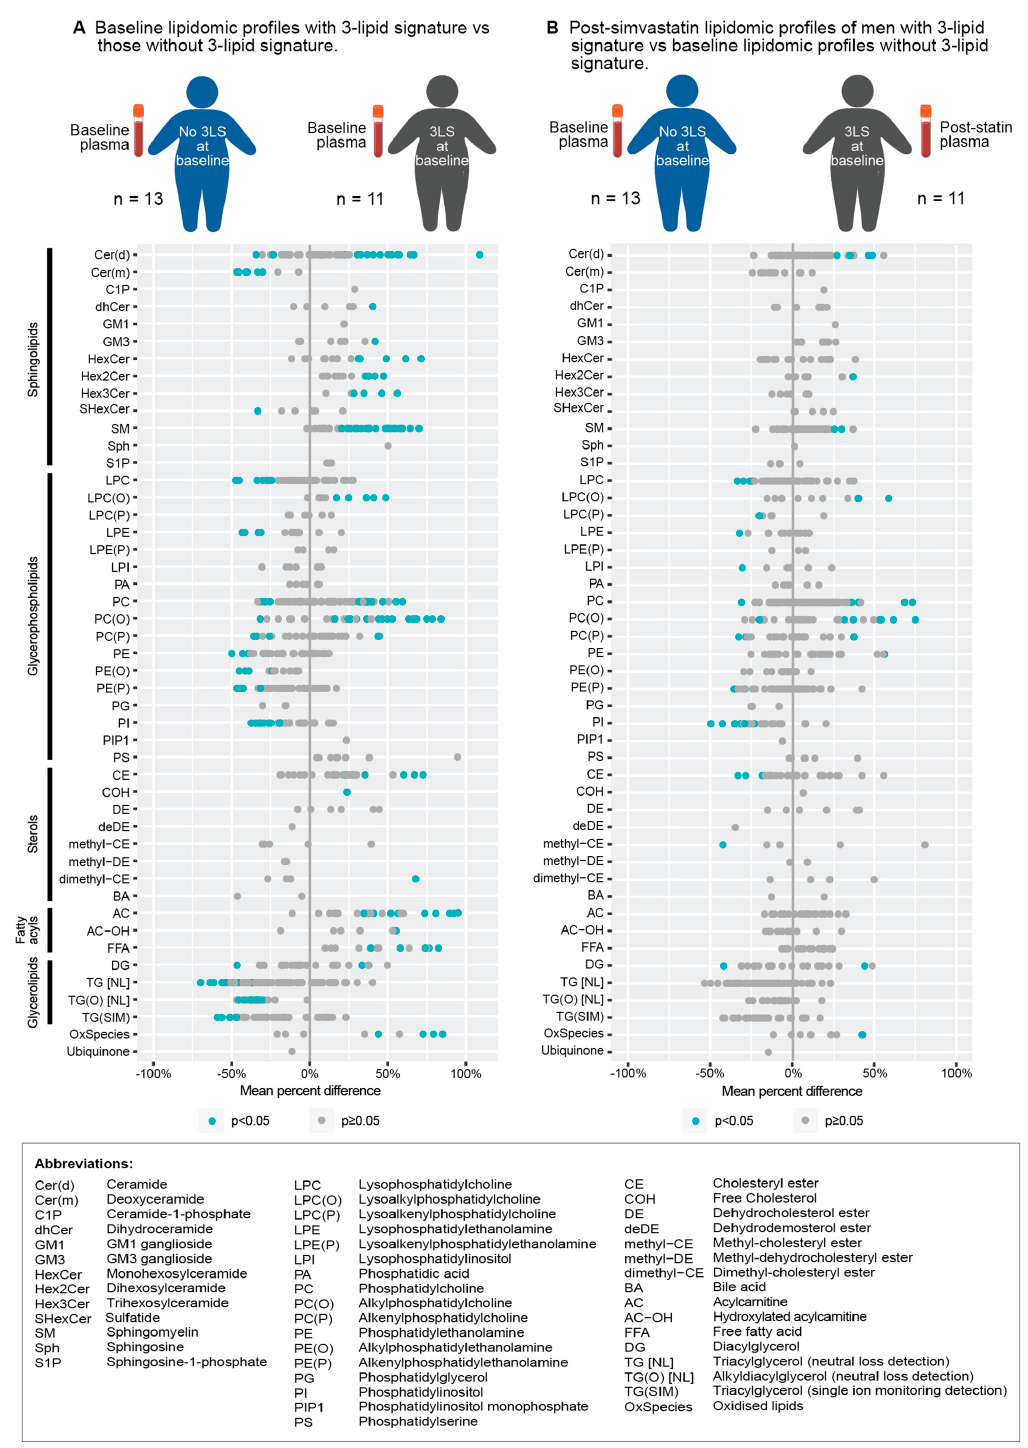
Figure 2. Mean percent difference of plasma levels of individual lipid species, grouped by lipid class, in two comparisons: ( A ) baseline lipidomic profiles with 3-lipid signature vs. those without 3-lipid signature; and ( B ) post-simvastatin lipidomic profiles of men with 3-lipid signature vs. baseline lipidomic profiles without 3-lipid signature. Each datapoint represents a lipid species within the lipid class. Blue datapoints indicate statistically significant differences with p -value < 0.05 by t